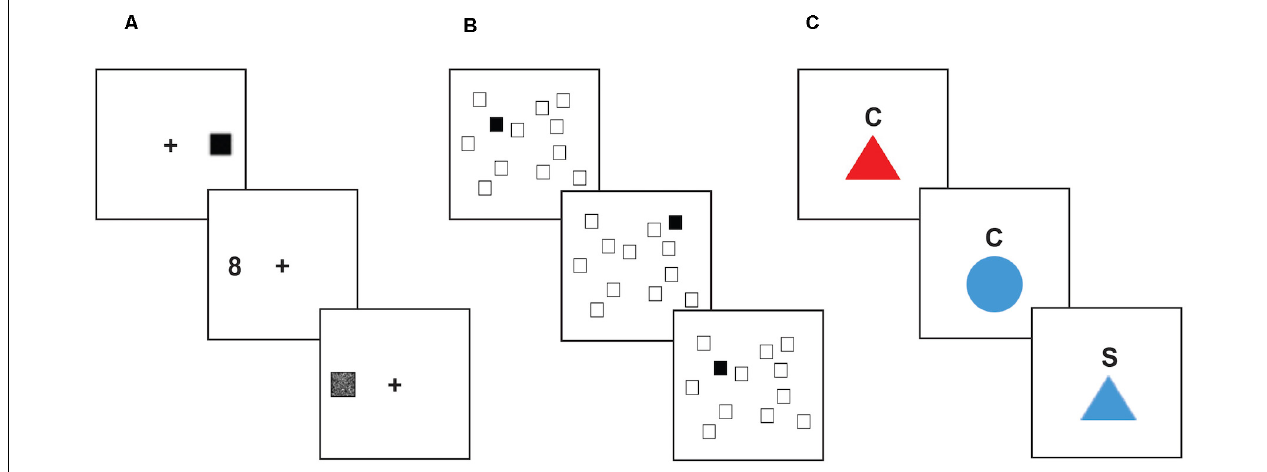
FIGURE 1 | Executive function tasks. Stimuli shown are not to scale. (A) Antisaccade task . For each trial, the participant focused on a fixation point at the center of the screen. After a variable amount of time, a small black square would appear on one side of the screen, quickly followed by a number (between 1 and 9) appearing on the opposite side of the screen. The participant was instructed to inhibit their saccade to the visual distractor, and instead quickly look to the target stimulus to identify it before it was covered up, and then report the number they saw to the research assistant. (B) Spatial n-back task . In each block of this task, the participant saw a display of twelve white squares distributed across the screen. On each trial, one square in the display turned black. The participant was instructed to respond by pressing a button to indicate whether the black square appeared in the same spatial location as the black square two trials earlier. (C) Color-shape task . On each trial, a stimulus appeared in the center of the screen below a cue letter (C or S) indicating whether the participant should categorize the shape based on color (red or blue) or shape (circle or triangle). Trial types were interspersed such that participants were required to assess on each trial whether to use the same categorization rule as the previous trial (“repeat” trials), or if they needed to switch to the other categorization rule (“switch” trials).